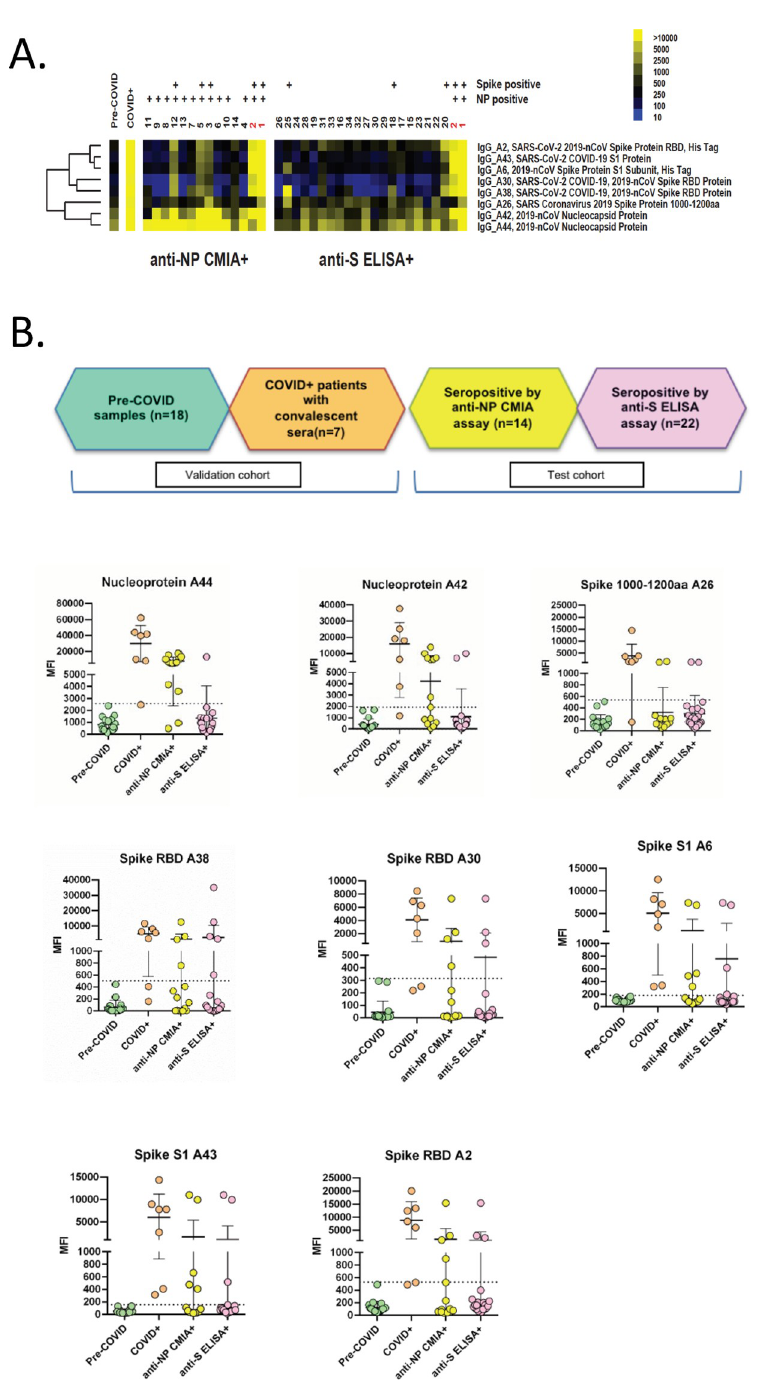
Fig 2. Heatmap and graph of SARS-CoV-2 reactivity in study samples on antigen microarrays. A) Heatmap of eight SARS-CoV-2 IgG reactivities in individual anti-NP CMIA+ and anti-S ELISA+ samples. These antigen reactivities represent the eight highest ranked IgG reactivities that are upregulated in COVID+ samples (with mean MFI-B > 1000) as determined by significance analysis of microarrays. Anti-NP and anti-spike reactivity in individual samples on the arrays is indicated above the sample numbers. Positivity on the arrays was determined as described below. The mean reactivity of pre-COVID and COVID+ samples is shown as a comparison. The sample numbers in red indicate dual positive (anti-NP CMIA+ and anti-S ELISA+) samples. Yellow indicates high reactivity, whereas blue indicates low reactivity on the heatmap. B) Graphs of individual antigen IgG reactivity (MFI-B) in pre-COVID, COVID+, anti-NP CMIA+ and anti-S ELISA+ groups. Graphs show mean ± SD for samples in each of the